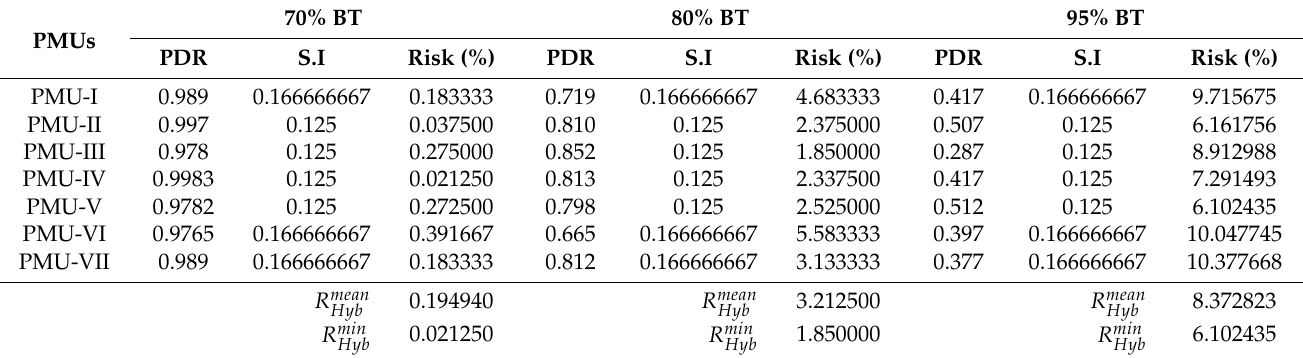
Table 6. Simulation results of hybrid SCN with 64 Kbps data rate under varying BT.